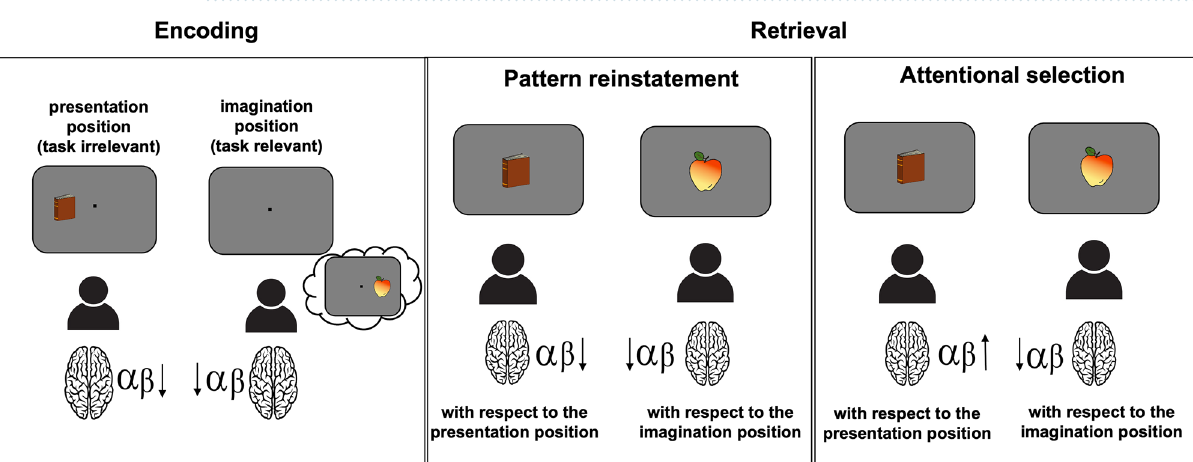
Figure 2. Schematic illustration of the hypotheses. Based on previous research 17,18 , we expect to find a contralateral alpha-beta decrease with respect to both the presentation position, as well as to the imagination position in the encoding phase. As for the retrieval phase, two alternative hypotheses were formulated. If lateralized alpha-beta-band activity reflects pattern reinstatement, a contralateral alpha-beta decrease is expected both with respect to the presentation and to the imagination position. However, if alpha-beta oscillations reflect attentional selection mechanisms, a contralateral alpha-beta increase with respect to the task-irrelevant information and a decrease with respect to the task-relevant information is